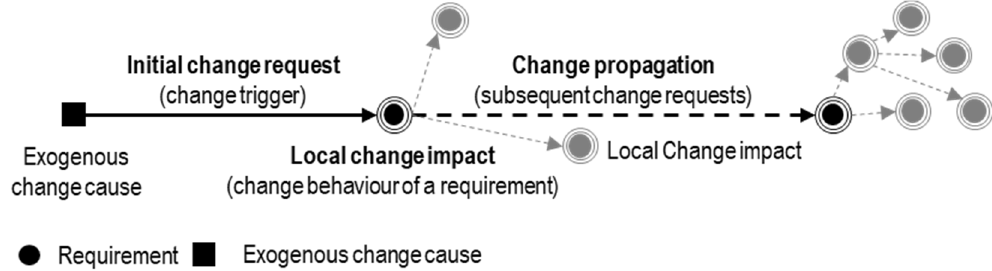
Figure 3. Differentiation of initial and subsequent changes from a change propagation perspective .